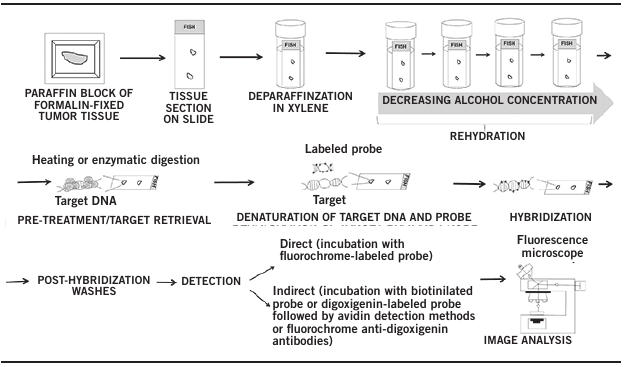
figurE 4 − Standard steps of FISH LOH screening FISH: fluorescence in situ hybridization; LOH: loss of heterozygosity; DNA: deoxyribonucleic acid. Eight basic steps are included: deparaffinization in xylene, rehydration in graded alcohols, pre-treatment/target retrieval, denaturation of target DNA and probe, hybridization, post-hybridization washes, direct or indirect detection and image analysis in a fluorescence